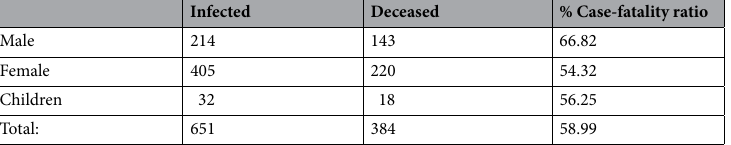
Table 6. Data recovered from the register of friar Francesco Da Gazzo, recording the arrival and death of plague victims at the Lazaretto dell’Osservanza (June–August